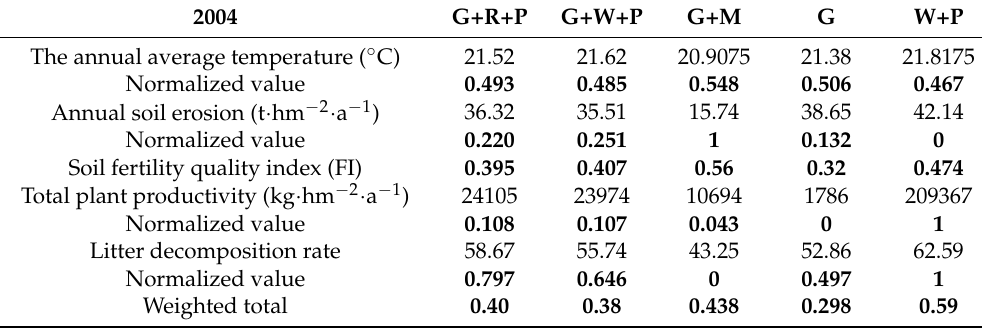
Table A1. Ecological indicator values from three mixed Ginkgo systems, pure Ginkgo (G), and a cropping system (W+P), in 2004.